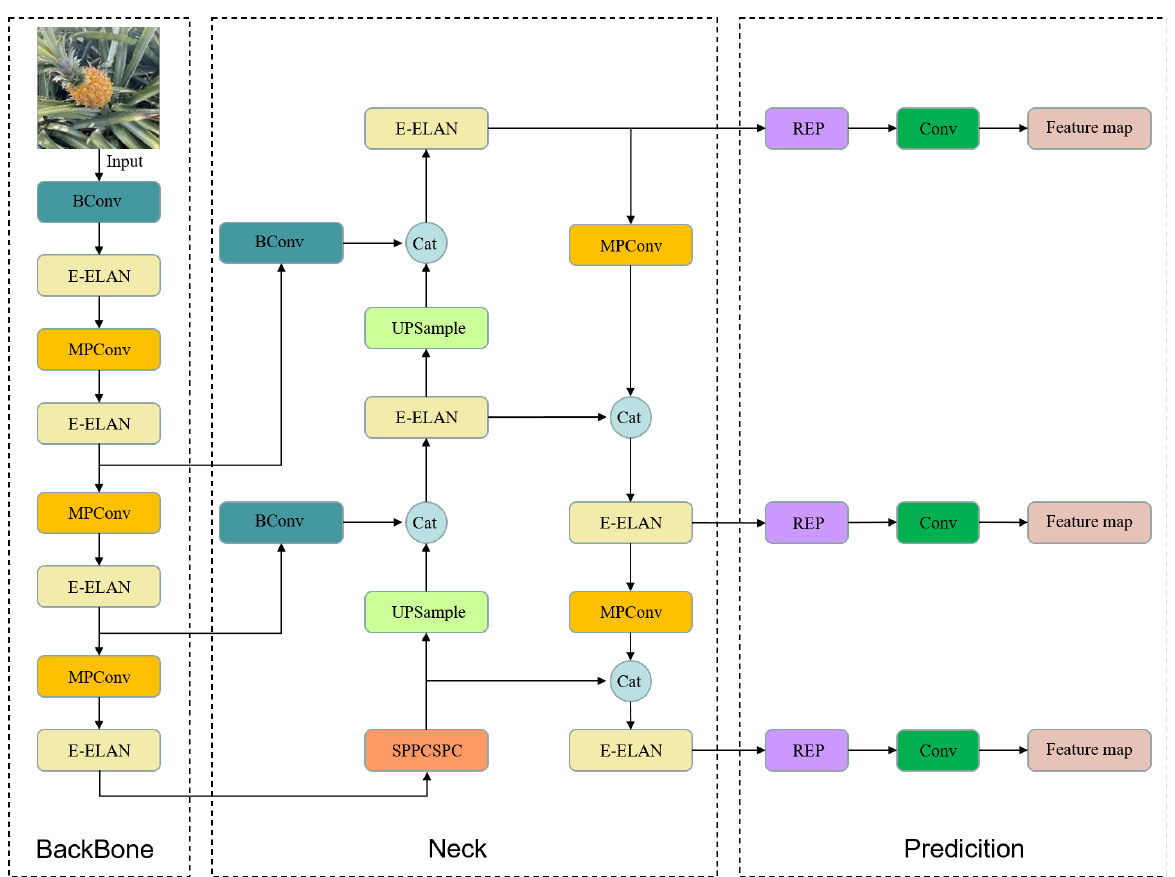
Figure 4. The network structure of the original YOLOv7.